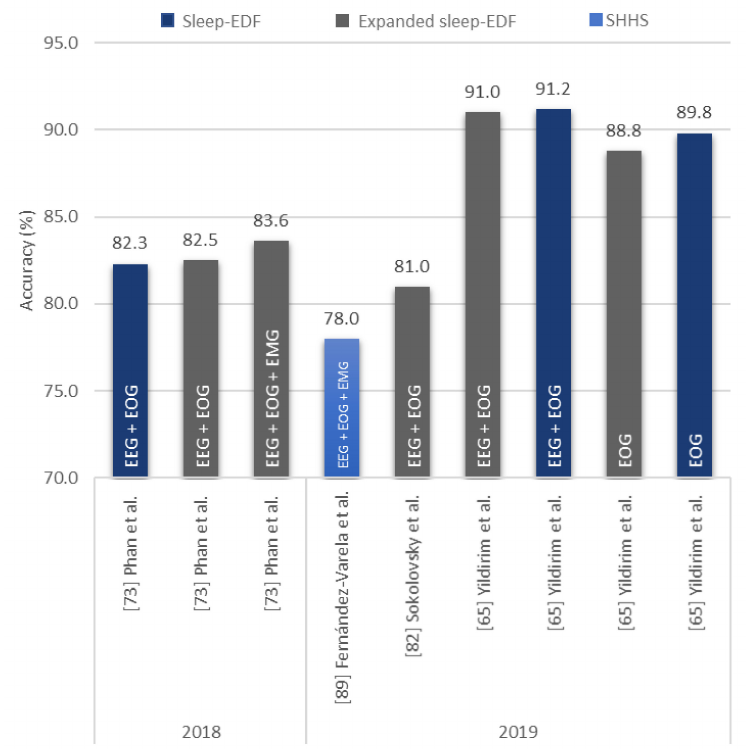
Figure 10. Performance of CNN-based models analyzing only EEG signals. Sleep datasets are presented in di ff erent colors. * Summary statistics: Various sleep databases used to develop CNN models for sleep stage detection.